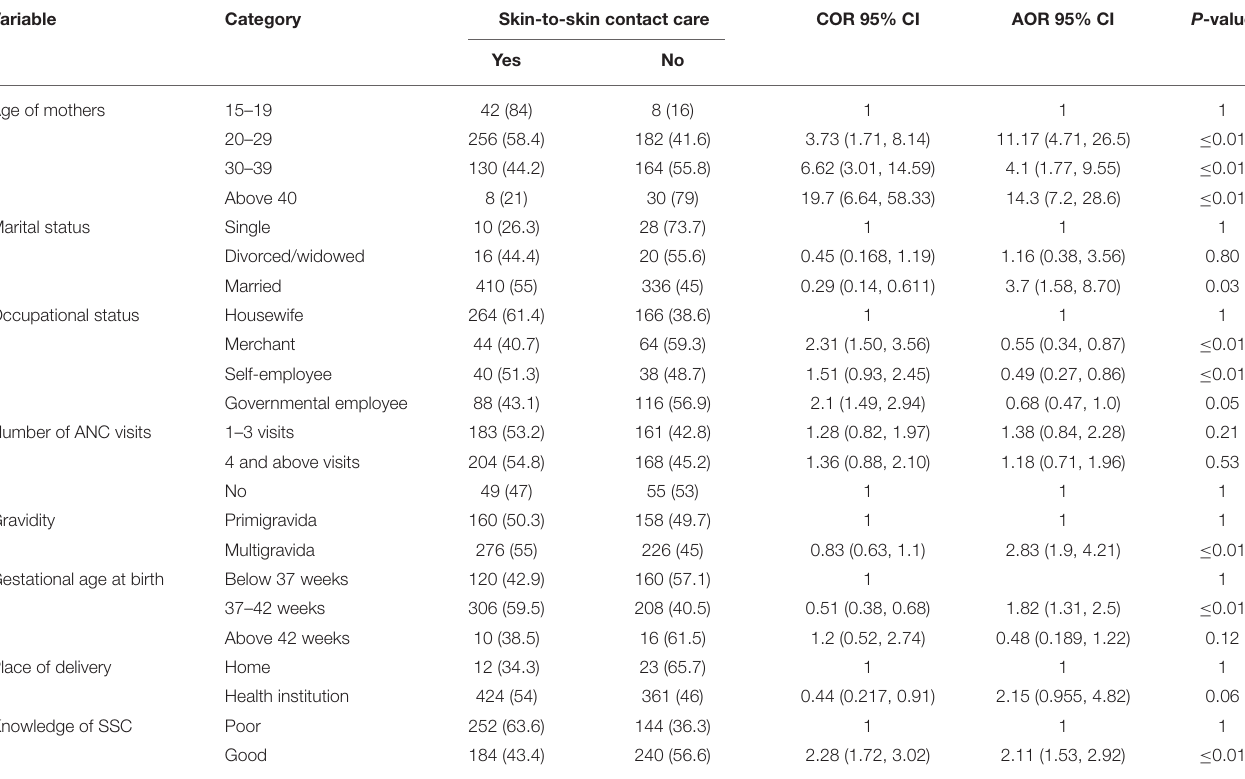
TABLE 3 | Determinants of Skin-to-skin contact practice among post-partum women at public hospitals in eastern Ethiopia, 2021.